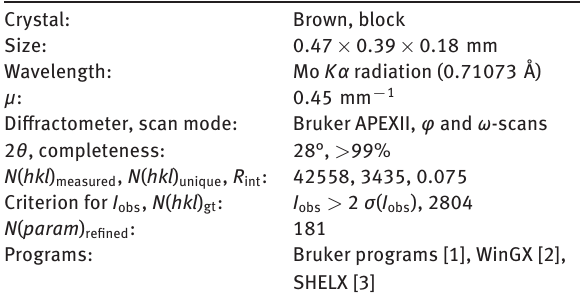
Table 2: Fractional atomic coordinates and isotropic or